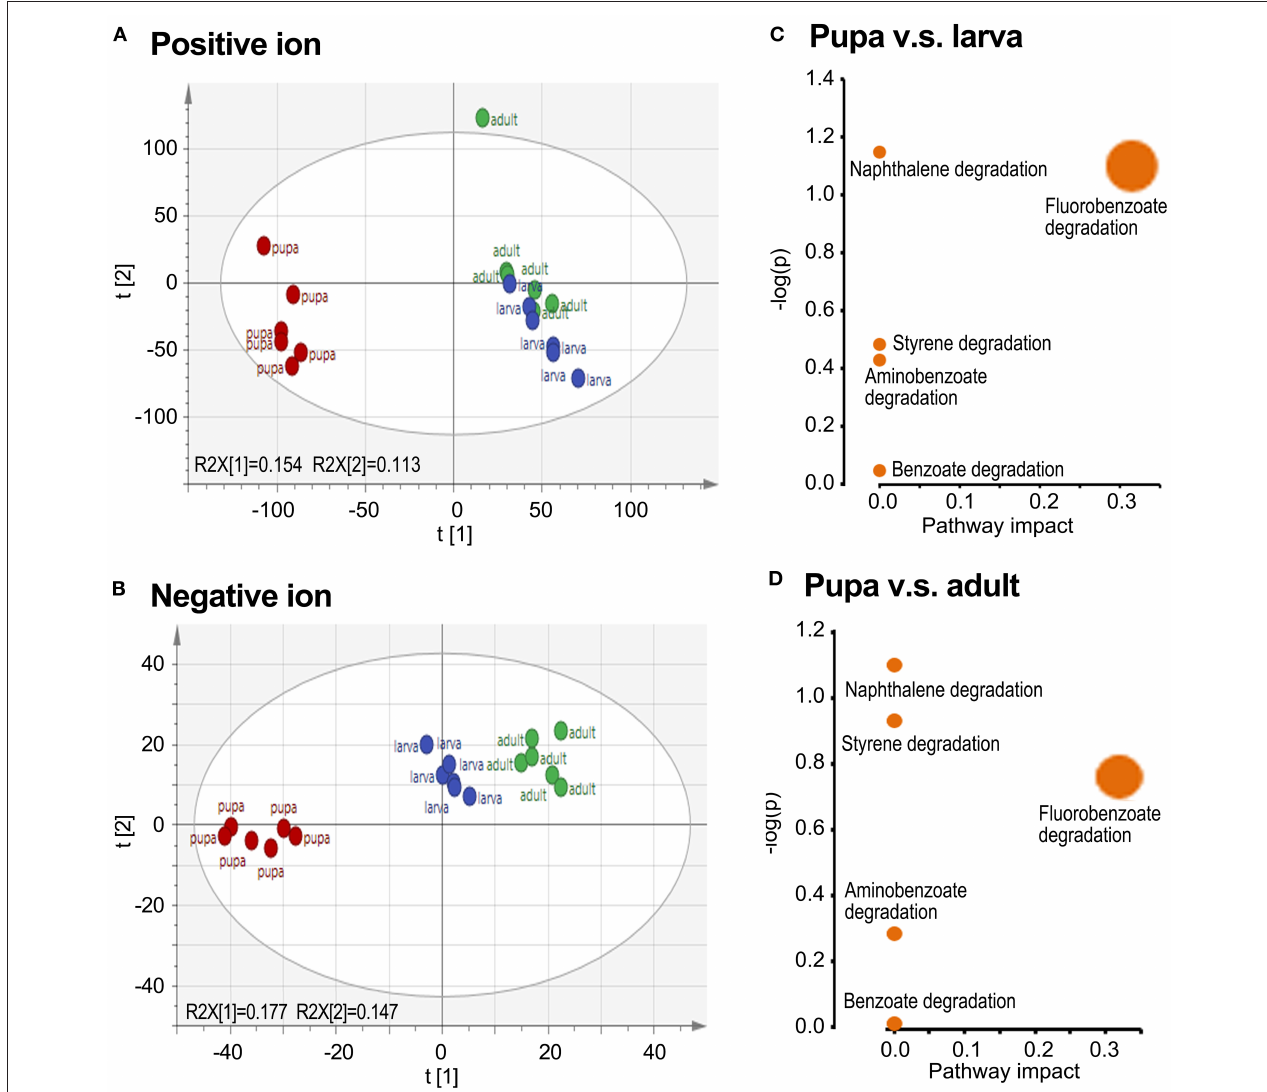
FIGURE 2 | Grouping comparison of metabolomics in larvae, pupae, and adults in L. decemlineata . The ultra-performance liquid chromatography–quadrupole–time of flight mass spectrometry (UPLC-Q-TOF-MS) data were analyzed by principal component analysis (PCA). Positive and negative ion mode PCA score maps (A,B) and pathway enrichment analyses (C,D) of larva, pupa, and adult groups are shown. Different colors in the (A,B) represented different groups and each point represented a